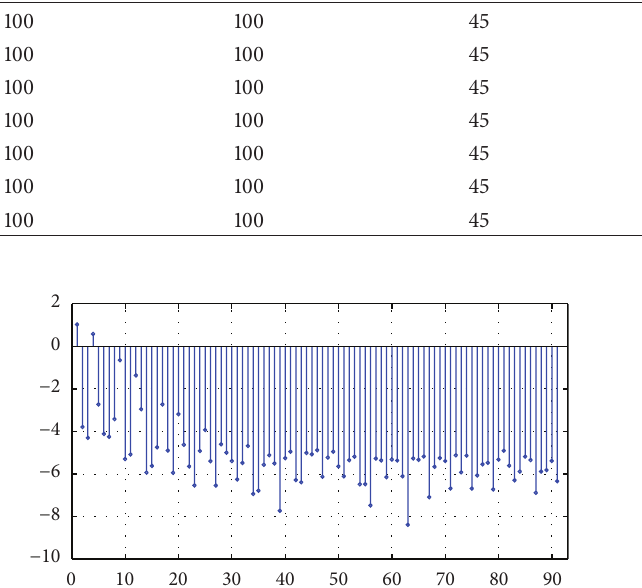
Collected values per sections 𝑆